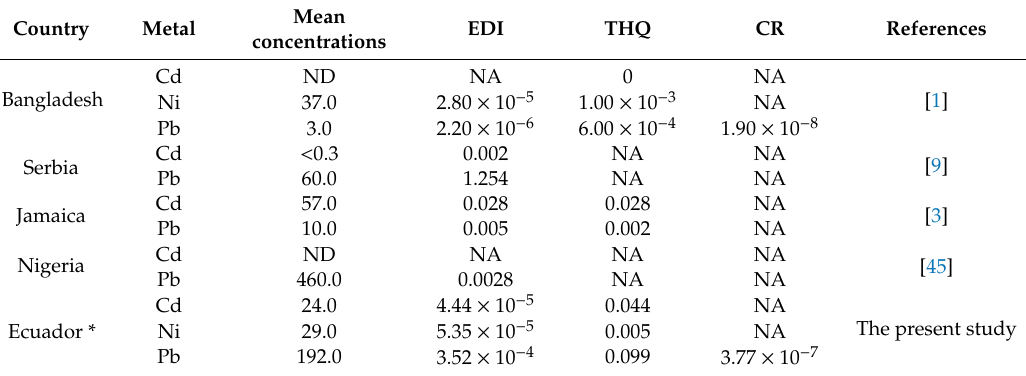
Table 2. Comparison among similar studies done, a summary of cadmium (Cd), nickel (Ni), and lead